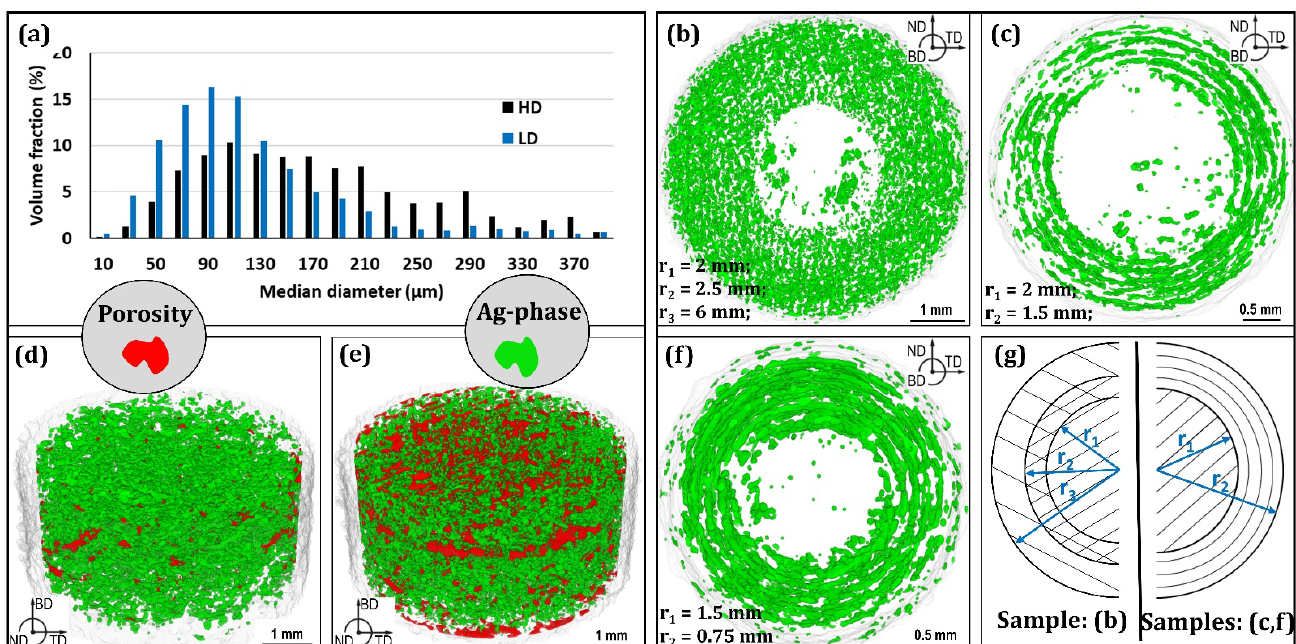
Figure 5. 3D-distribution of AgCaLa phases analyzed via µ-CT: ( a ) size distribution of AgCaLa phases; ( d ) HD, homogenous distribution of AgCaLa phases; ( e ) LD, homogenous distribution of AgCaLa phases and pores; ( b , c , f ) samples with a graduated distribution of AgCaLa phases by variation of LBM parameters; ( g ) schematic illustration of the parameter variation used for samples ( b , c , f ).